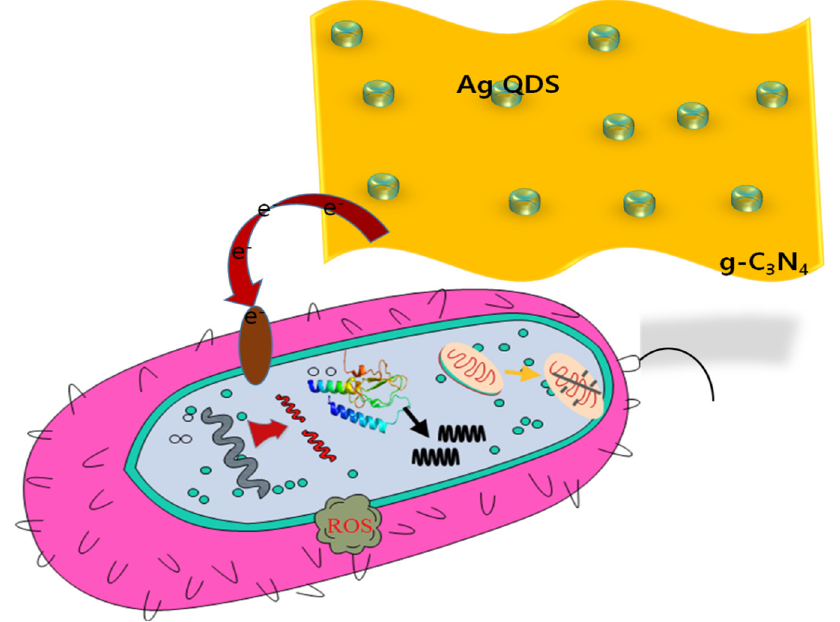
Figure 13. The hypothetical antimicrobial mechanism of Ag/g-C 3 N 4 nanostructures. Table 1. The performance of the antibacterial activities of prepared nanomaterials against different bacterial strains.